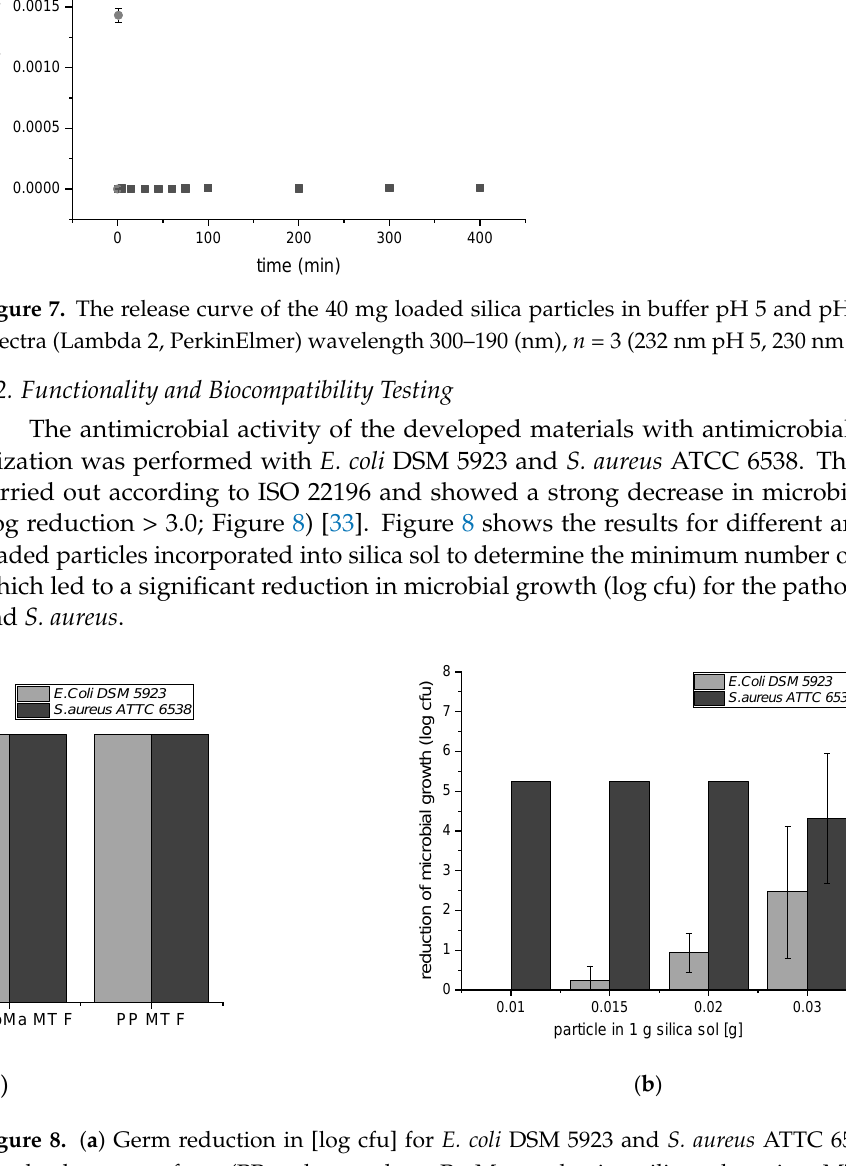
Figure 7. The release curve of the 40 mg loaded silica particles in buffer pH 5 and pH 3, UV–Vis spectra (Lambda 2, PerkinElmer) wavelength 300–190 (nm), n = 3 (232 nm pH 5, 230 nm pH 3).